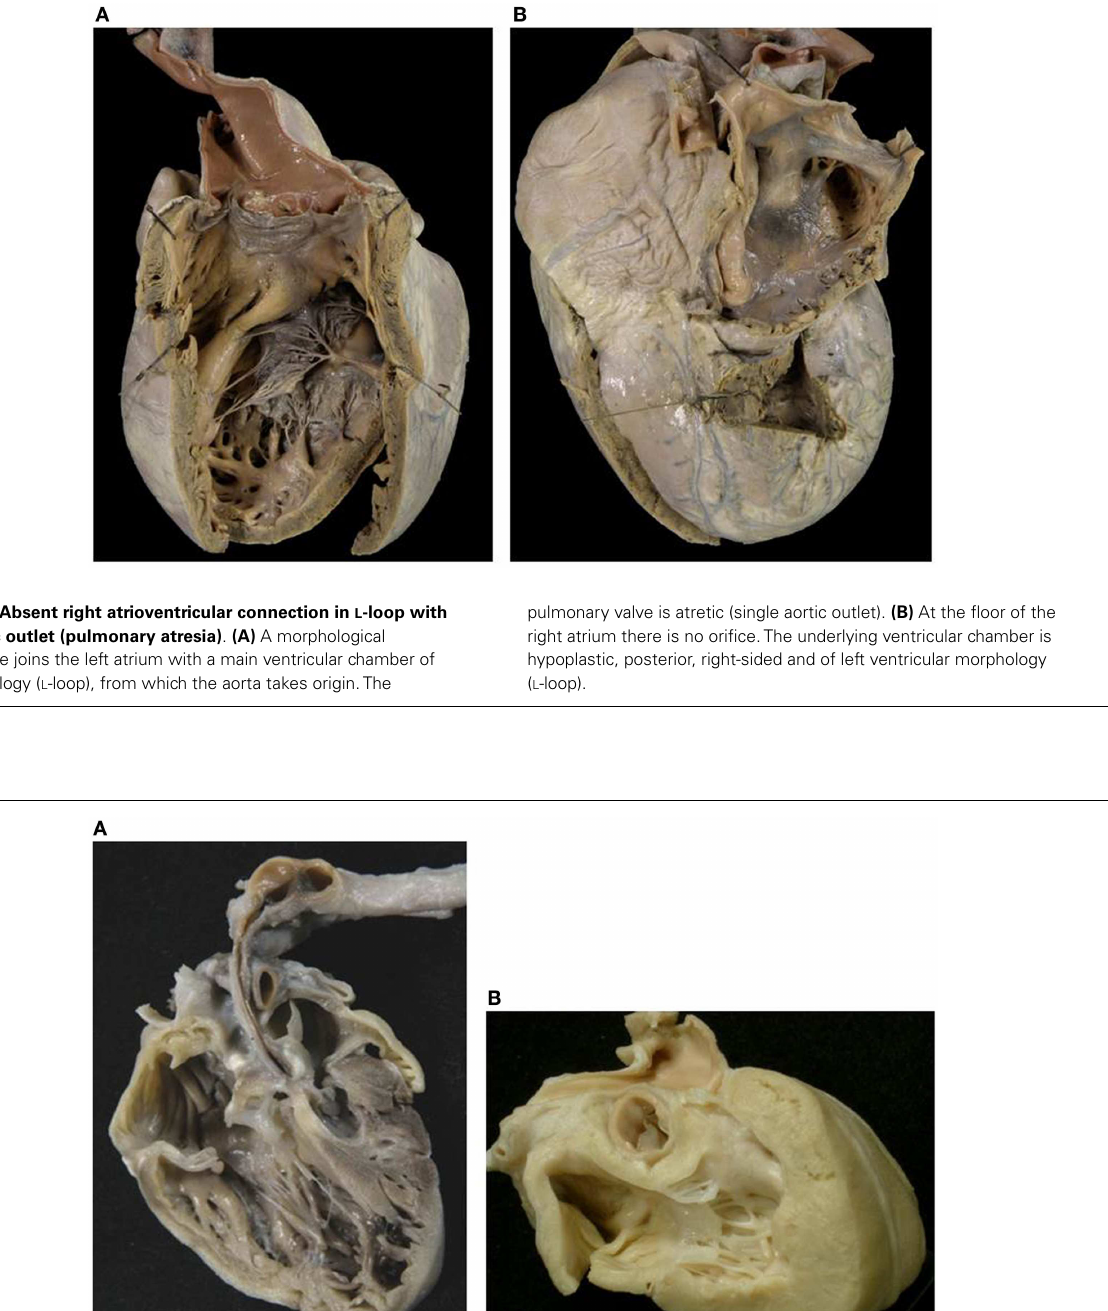
ventricle.This heart is only suitable for Norwood univentricular repair. (B) Pulmonary atresia with intact ventricular septum (single aortic outlet) with hypoplastic right ventricle.The size of the right ventricle is such that this heart may be suitable for one and half ventricle